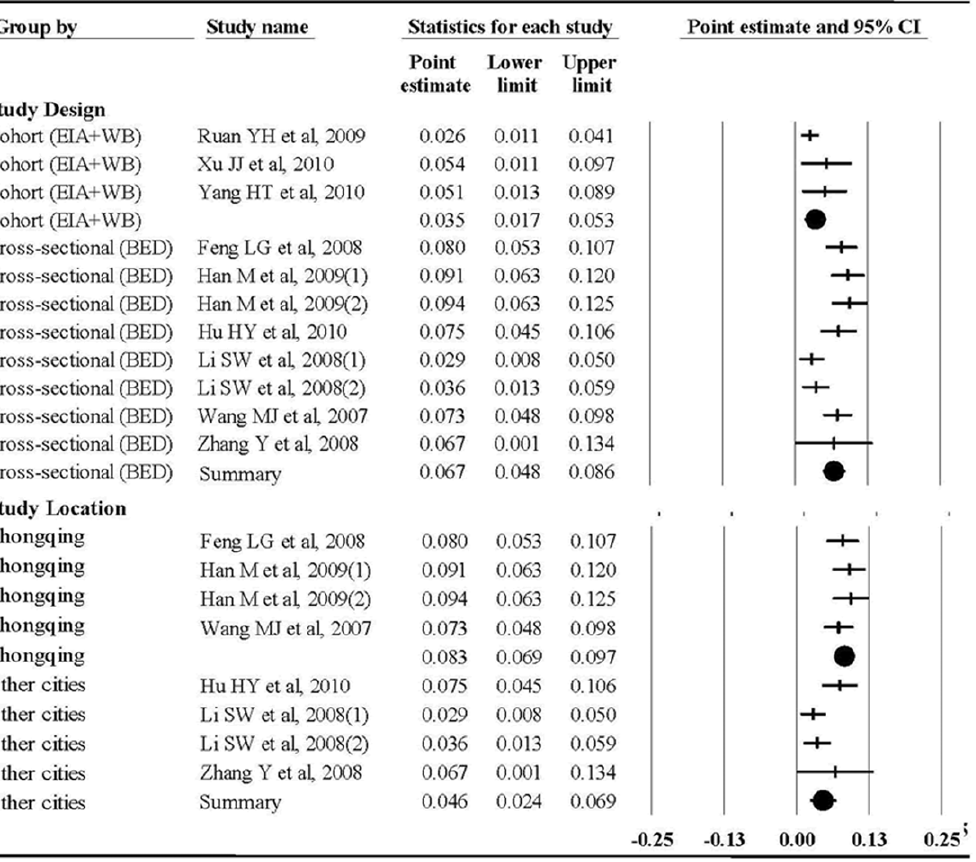
Figure 2. Crude results based on meta-analysis of studies assessing HIV incidence by study design, and study location.